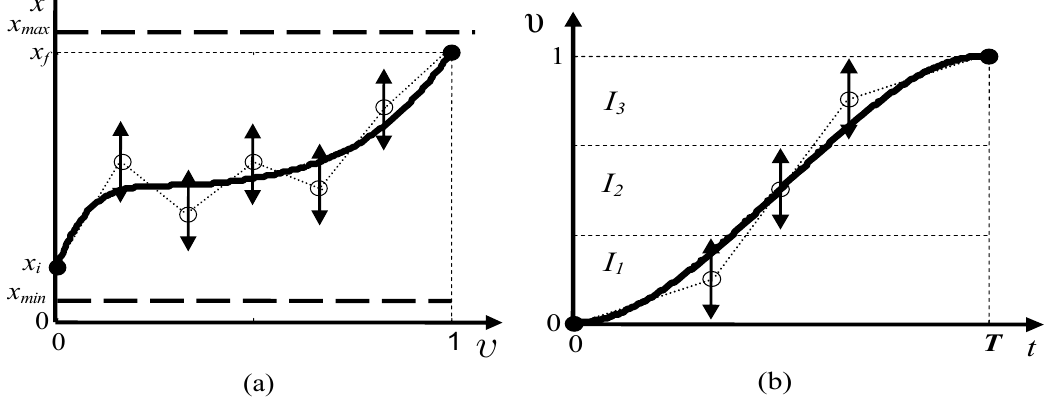
Figure 13. Path and motion profiles. ( a ) A path component profile and ( b ) the motion profile.